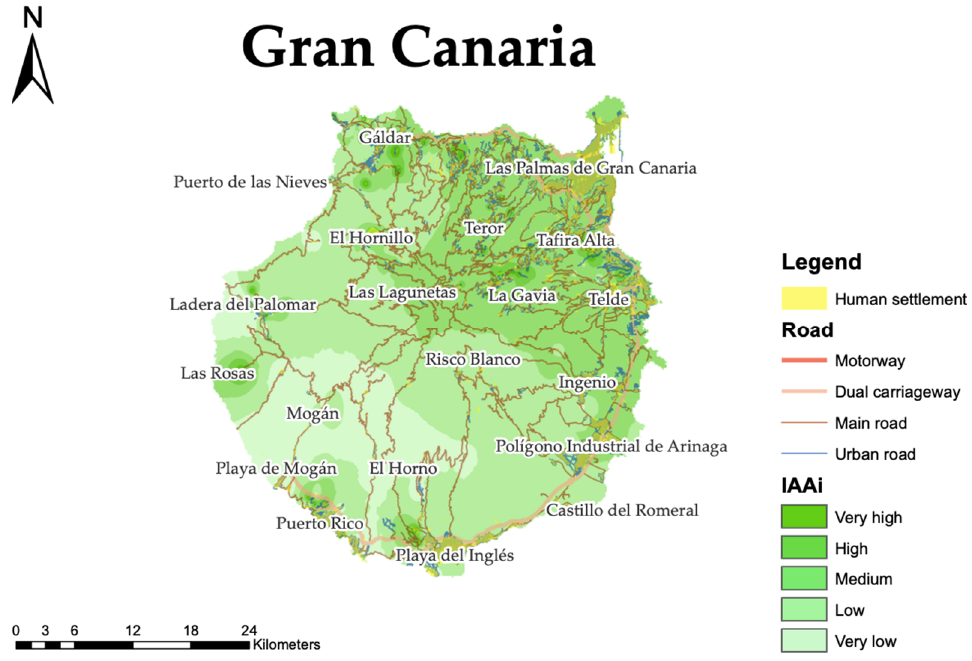
Figure 3. Thematic cartography regarding the accessibility levels in the Island of Gran Canaria (Source: authors).